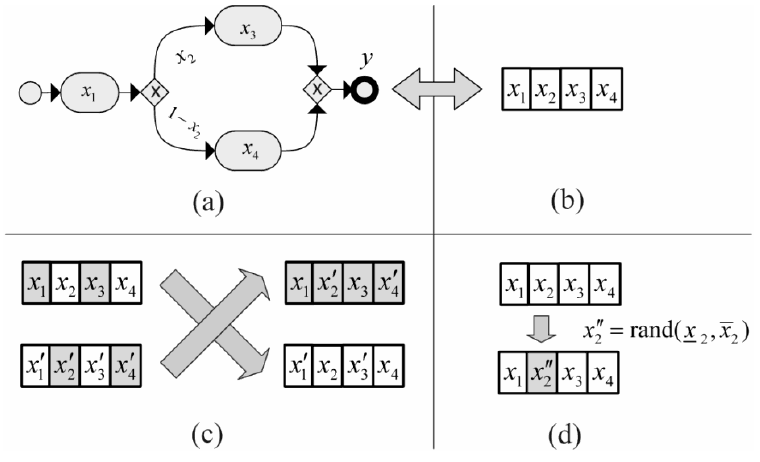
Figure 9. The chromosome coding ( a , b ), the crossover ( c ) and the mutation ( d )